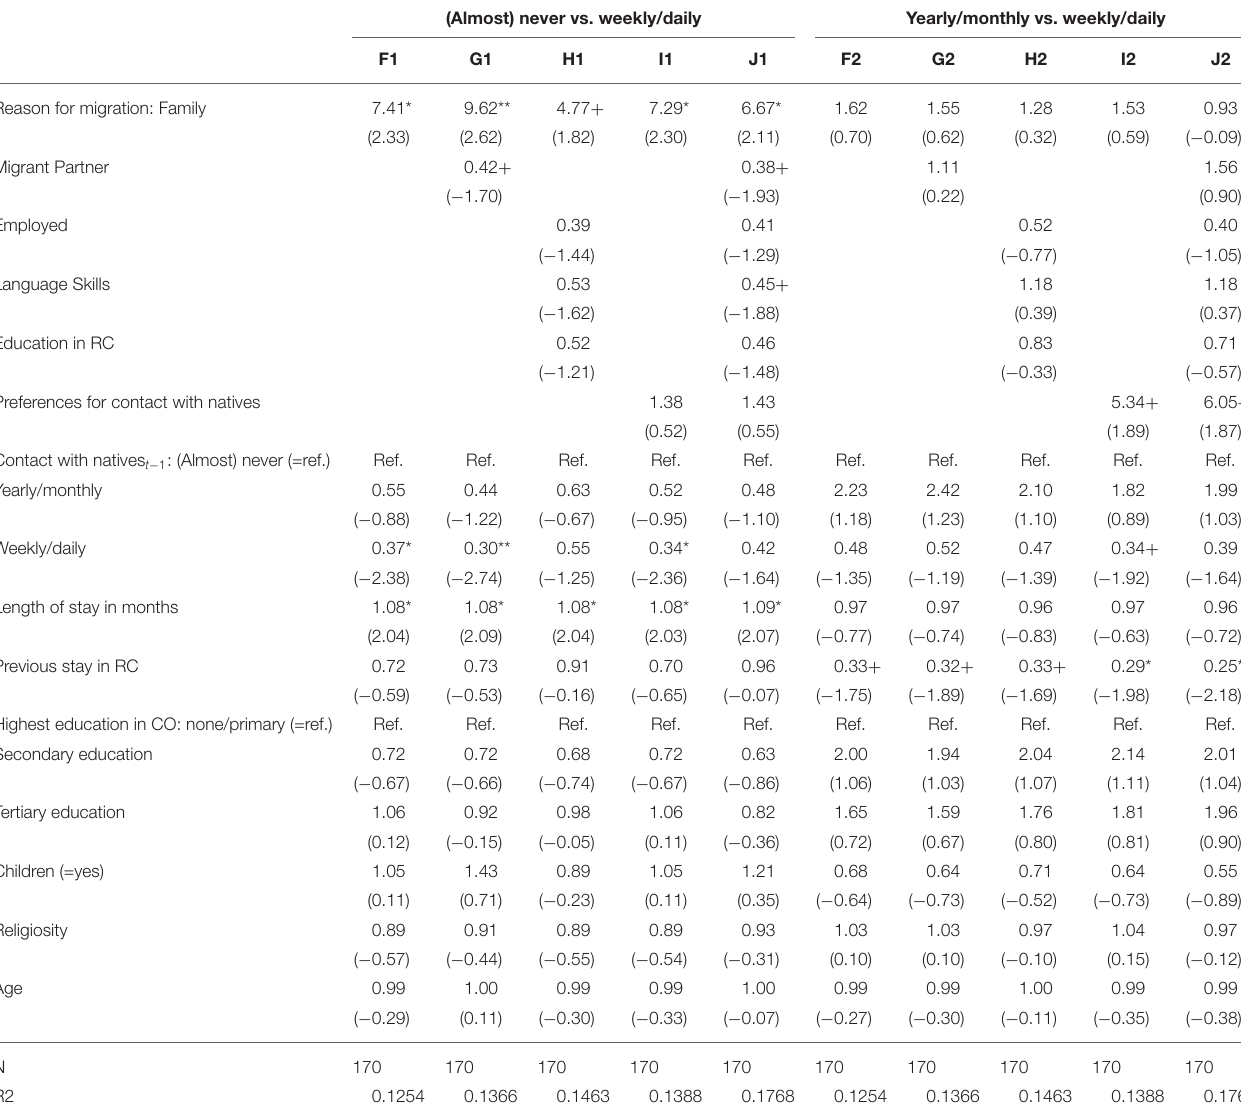
TABLE 3 | Multinominal Logistic Regression Analysis (Relative Risk Ratio): Impact of family influence, opportunity and preferences on time spend with natives, female